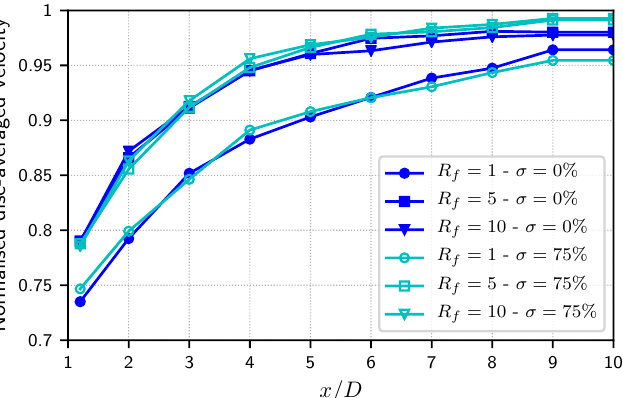
Figure 8. Comparison of the numerical disc-averaged velocities obtained for three filling ratios R f and two standard deviations σ ( λ ) (TSR = 3.67, λ = 4.5 m, I ∞ =